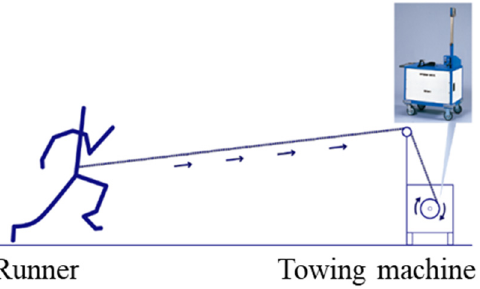
Figure 2. Supramaximal running in a towing system. The towing machine comprises an electric motor, a powder clutch, and a winch to wind rope. The powder clutch stabilizes the tension to pull the runner for